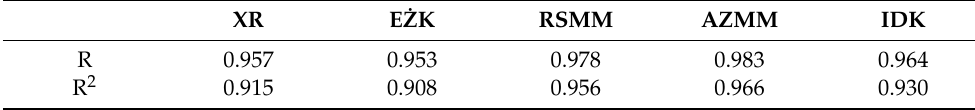
Table 2. Correlation and determination coefficients of tested